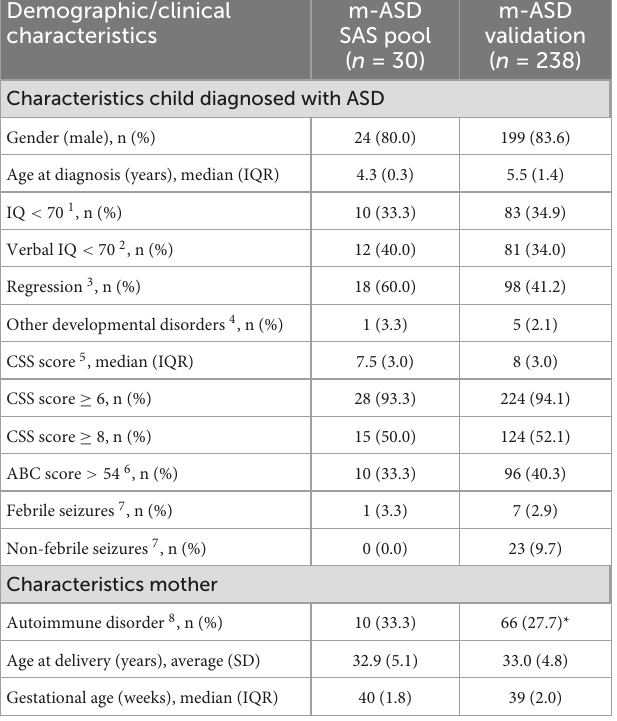
TABLE 1 Demographic and clinical characteristics of m-ASD samples from SSC used for SAS screening and validation. Demographic/clinical characteristics